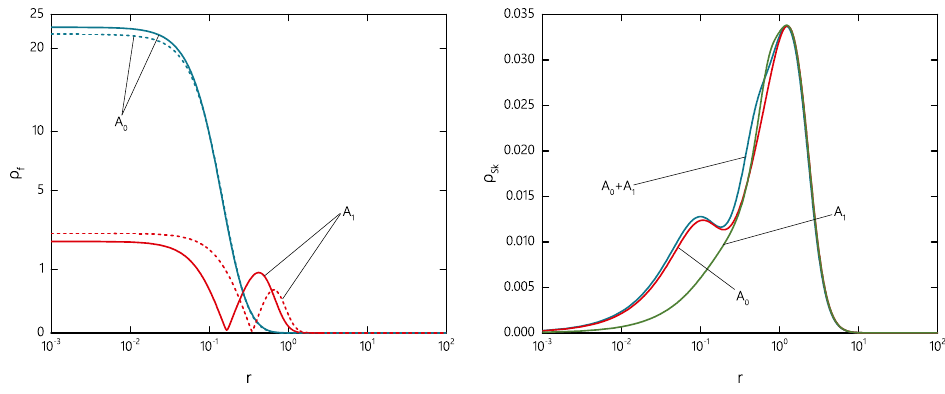
Figure 11 . Distributions of the fermionic density of the localized modes A 1 and A 2 (left plot) and the topological density of the Skyrmion coupled to these modes (right plot) as functions of the radial coordinate r at g = 100 and κ 0 = 0. The solid line corresponds to the state with filling factor 2, dashed lines correspond to the states with filling factor